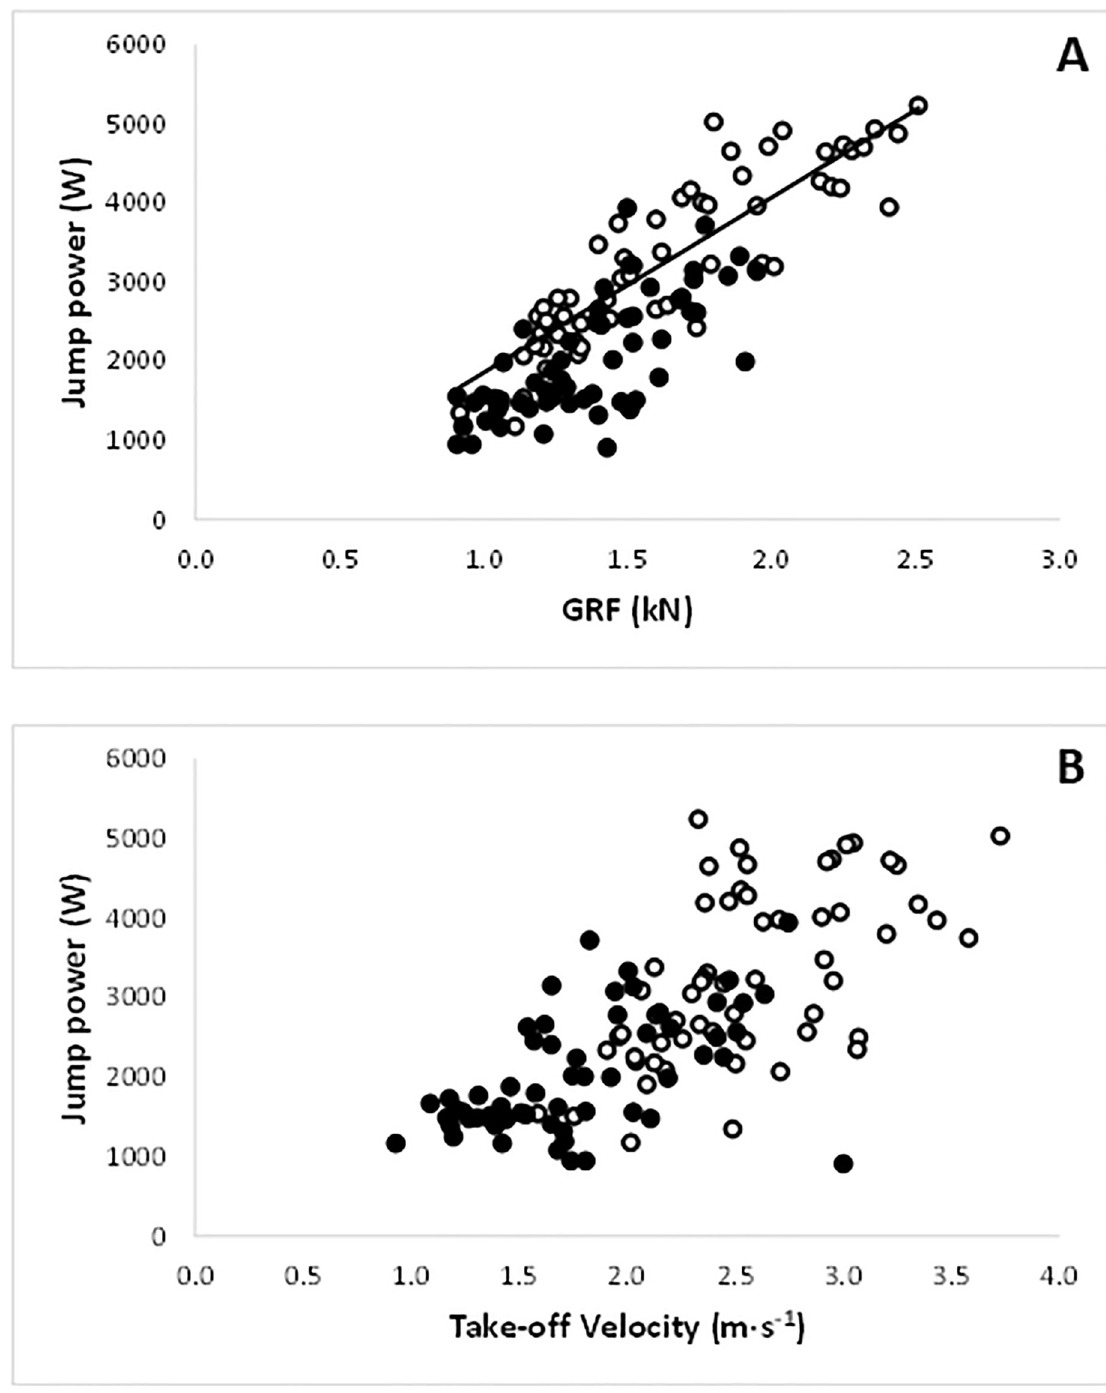
Fig 3. The peak power during a countermovement jump correlated with A) the peak ground reaction force (GRF) (correlation in young p < 0.001; old: NS) and B) and take-off velocity (V off ). � : Young; ● : Old.